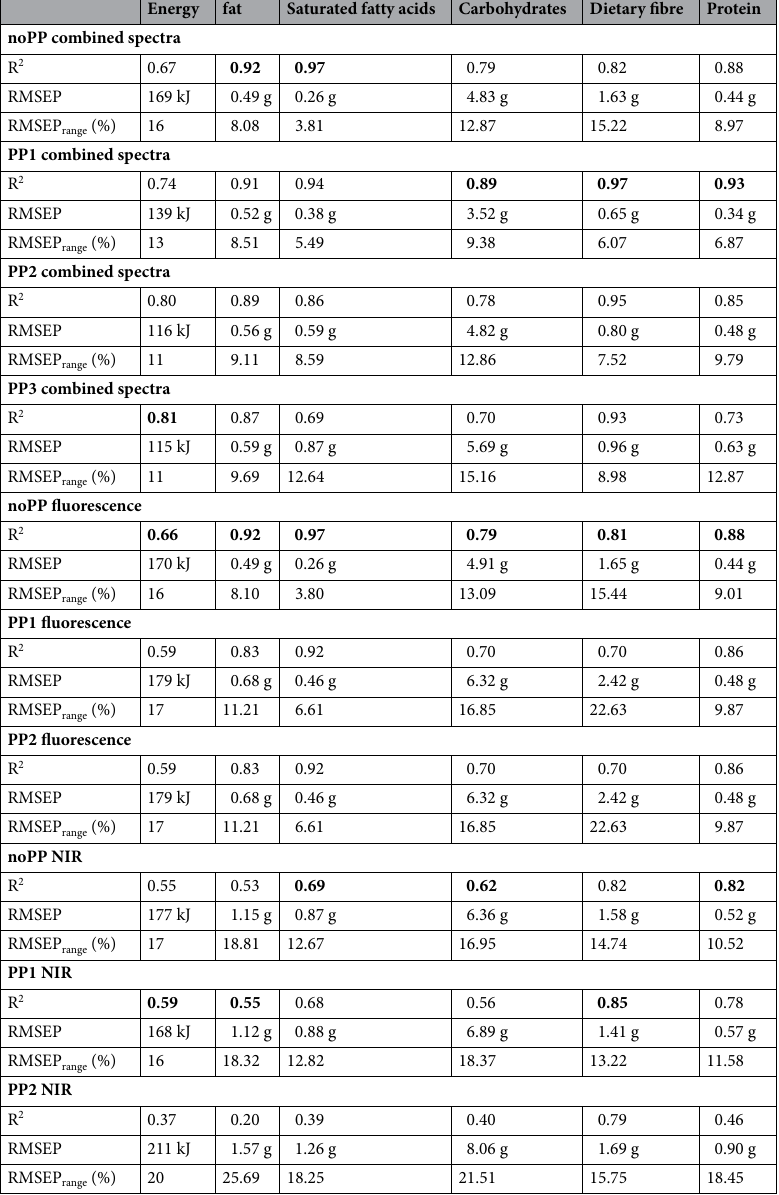
Table 4. Best PLSR prediction results for purchased samples (I-Y, DS1) with the given nutritional values by the manufacturers. R 2 is the coefficient of determination, RMSEP is the absolute root mean squared error of prediction, RMSEP range is the percentage error. PP is indicatesfor pre-processing, PP1: SNV, PP2: SNV and baseline correction, PP3: SNV, baseline correction and reducing factor for fluorescence spectra. Best coefficients of determination of the evaluation per data sets are presented in